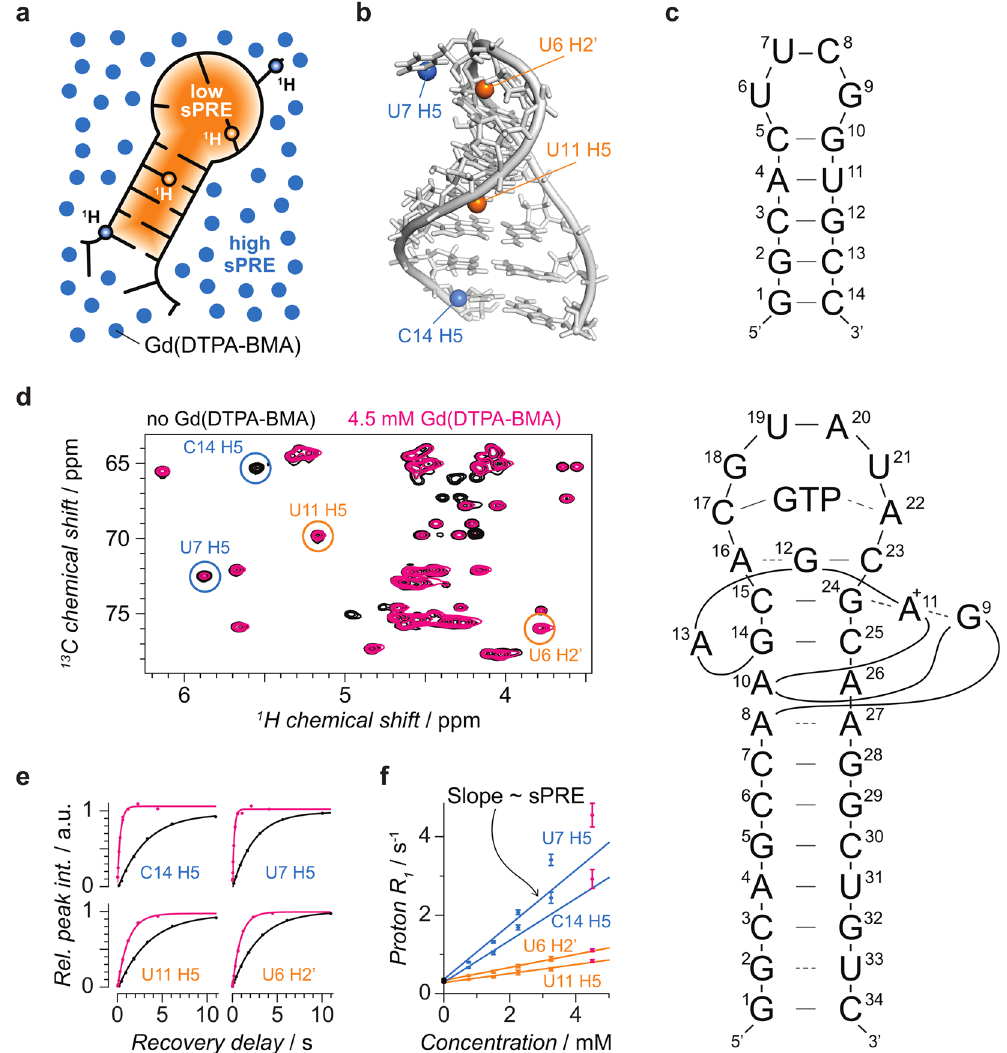
Figure 1. Concept of sPRE and exemplary sPRE data of the UUCG tetraloop. ( a ) sPRE data provide a quantitative measure for solvent accessibility and encode distance-to-surface information. sPRE data are acquired by titrating the RNA with the paramagnetic compound Gd(DTPA-BMA). ( b ) The NMR solution structure of the UUCG tetraloop (PDB code 2KOC) is shown and for illustration purpose, two solvent-exposed protons (blue spheres) and two buried protons (orange spheres) are highlighted. ( c ) Schematic representation of the UUCG tetraloop (top) and the GTP-bound GTP aptamer. ( d ) NMR spectra of the UUCG tetraloop are shown in the absence (black) and presence (magenta) of Gd(DTPA-BMA) with circles around the peaks corresponding to the protons shown in ( b ). ( e ) Quantitative sPRE data are obtained by measuring the longitudinal proton R 1 relaxation rate as a function of the concentration of Gd(DTPA-BMA). ( f ) Proton R 1 rates increase linearly with the concentration of the paramagnetic compound and the slopes correspond to the sPRE values of the respective resonances highlighted in ( b